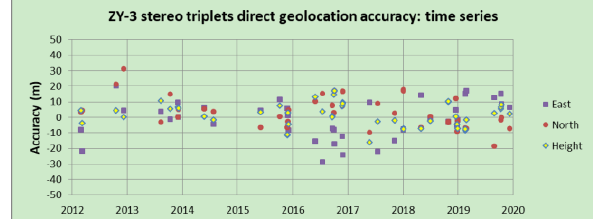
Figure 5. ZY-3 stereo triplets direct geolocation accuracy (time series).